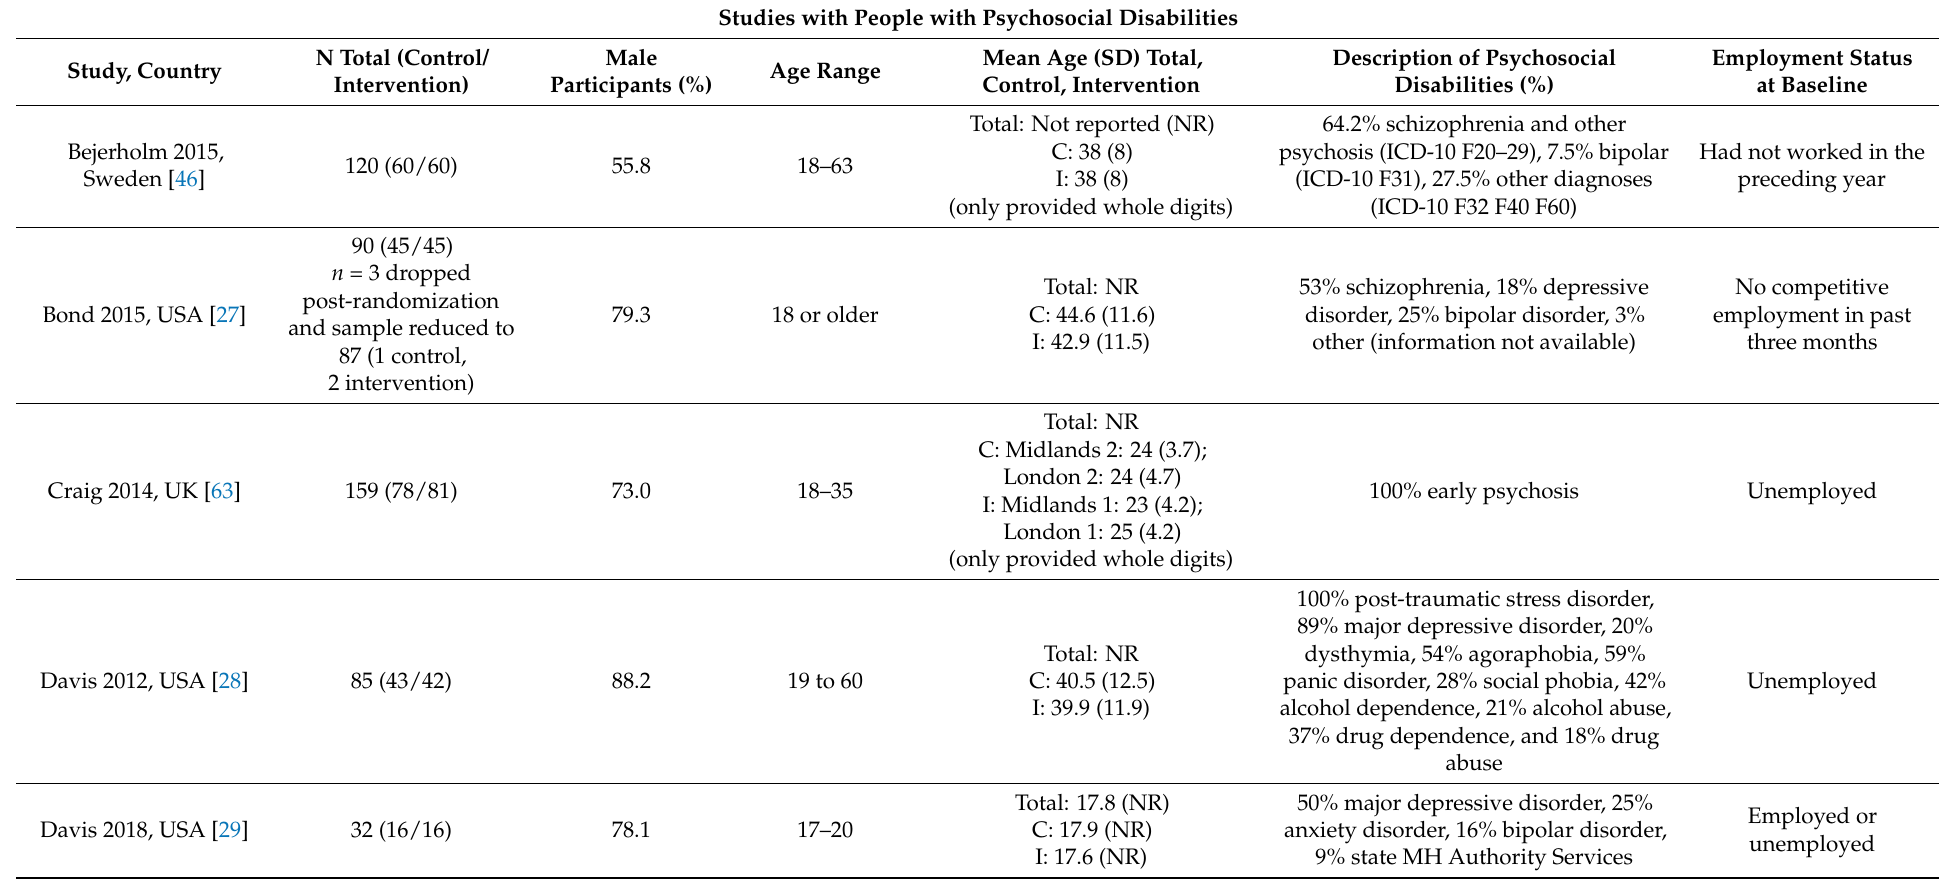
Table 1. Characteristics of included